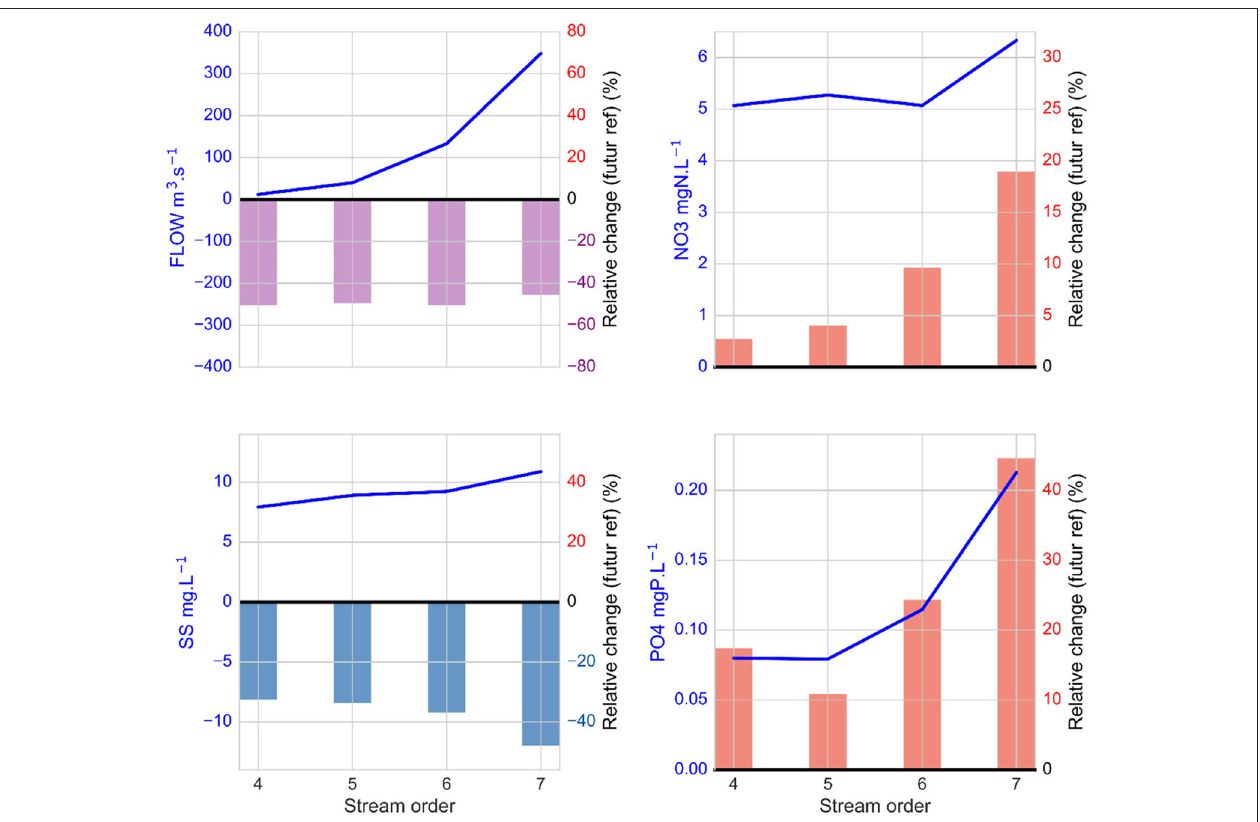
FIGURE 7 | Spatial impacts of climate change on relative changes in streamflow, suspended sediment, nitrate and phosphate concentrations in October/November in each Strahler order category of the Seine River basin with the driest scenario, RCP8.5 (ICHEC85_CLMcom). The relative change is the difference between 21-year averages for the 2080–2100 period and for the 1980–2000 reference period, averaged by order. The relative decrease in flow is indicated in violet and the relative positive and negative changes for other variables are indicated in red and blue, respectively. The reference values are represented by the blue